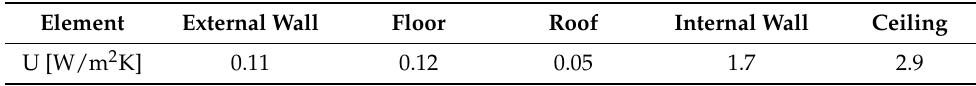
Table 4. Thermal transmittance of the construction materials.